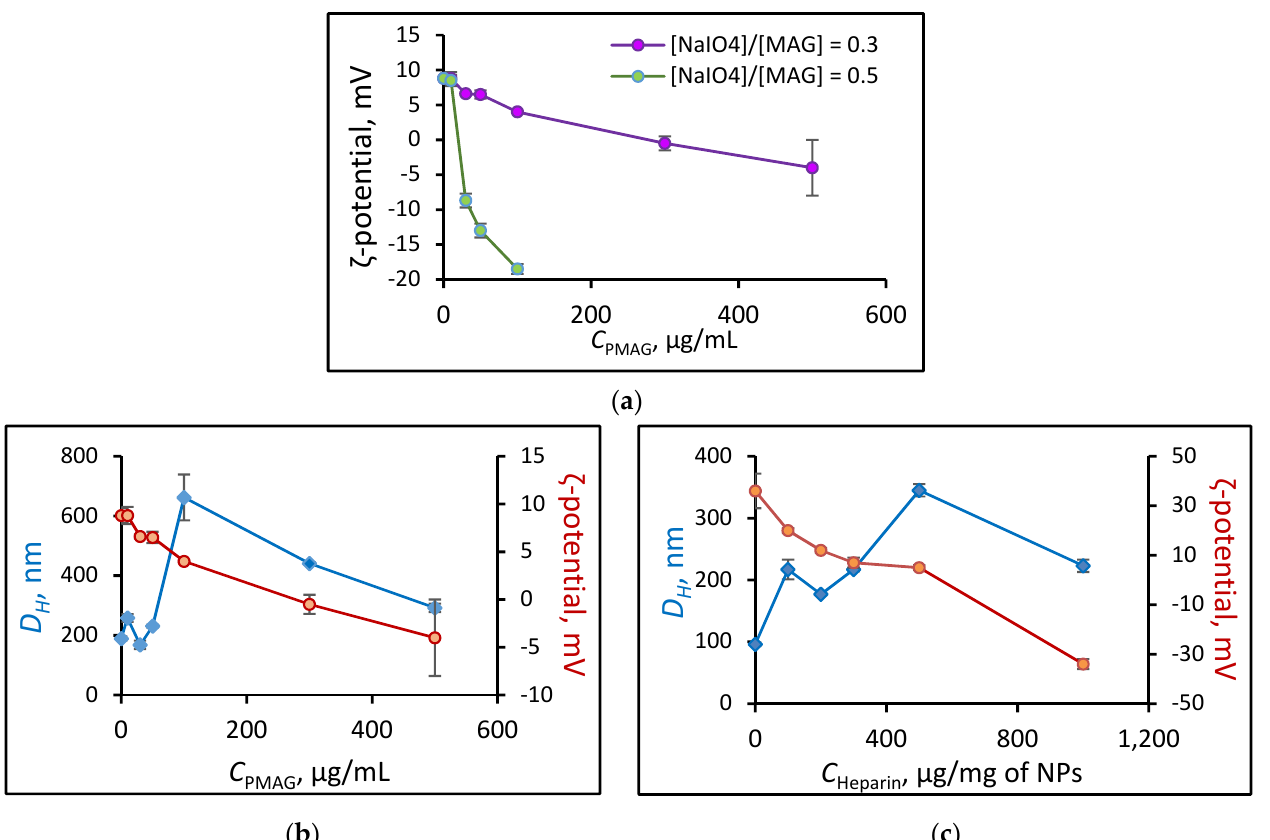
Figure 5. Dependence of (P(Lys- co - DL -Phe)-PMAG) particle ζ -potential on ox-PMAG concentration of different content of aldehyde groups ( a ) and dependence of P(Lys- co - DL -Phe) and P(Lys- co - D - Phe) particle size and ζ -potential on ox-PMAG (obtained at [NaIO 4 ]/[MAG] = 0.3) ( b ) and heparin concentration, respectively ( c ) (0.01 M PBS, рН 7.4, C NPs = 0.1